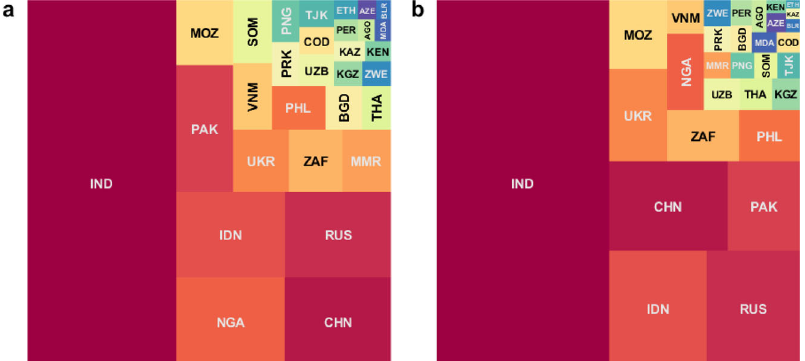
Fig. 4 Country-wise contribution to vaccine-avertable deaths from RR-TB. As for Fig. 2, the area of each square here is proportional to the median estimate from n = 200 posterior samples, for the absolute number of avertable rifampicin-resistant tuberculosis (RR-TB) deaths by a post-exposure, M72- like vaccine, between 2020 and 2035. Panel a shows deaths averted by a vaccine alone, while panel b shows deaths averted by a combination of a vaccine and measures to improve the management of RR-TB (both relative to a scenario of no vaccine, and no improvement in RR-TB, i.e. status quo). Countries are denoted by their ISO alpha-3 codes and their corresponding full names are listed in Table 1. Colours for each country are only for the purpose of display, and do not designate any quantitative Data and calibration . For each country we calibrated the model to a range of epidemiological and programmatic indicators, including the WHO estimates for TB incidence and mortality, strati fi ed by age group; the proportion of incident TB cases being RR-TB; and the proportion of TB incidence that occurred in those coinfected with HIV (Supplementary Table 7). For countries having a strong private sector healthcare presence, we assumed that all those surviving to the point of care-seeking are managed by either the public or private sector: by combining data for public sector noti fi cations with model projections for incidence and mortality, therefore, we aimed to estimate the proportion of patients being man- aged by the public vs private sectors. For countries with a driving role of HIV in the TB epidemic, we obtained ART coverage from UNAIDS, for simplicity assuming a linear scale-up to current levels 32 . We calibrated the model using Adaptive Markov Chain Monte Carlo 39 , which allows systematic propagation of uncertainty from model inputs to model projections, while updating the proposal distribution at each iteration. We reduced autocorrelation by taking every 150th sample and discarded the fi rst 20,000 samples, to yield 200 samples overall (Supplementary Methods 2). We calculated 2.5th and 97.5th percentiles as the 95% credible intervals, and the 50th percentile as point estimates, on these samples and on